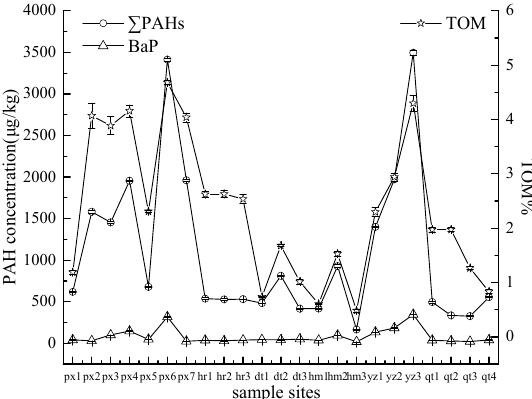
Figure 2. PAHs concentrations and TOM content in each soil sample (see supplementary